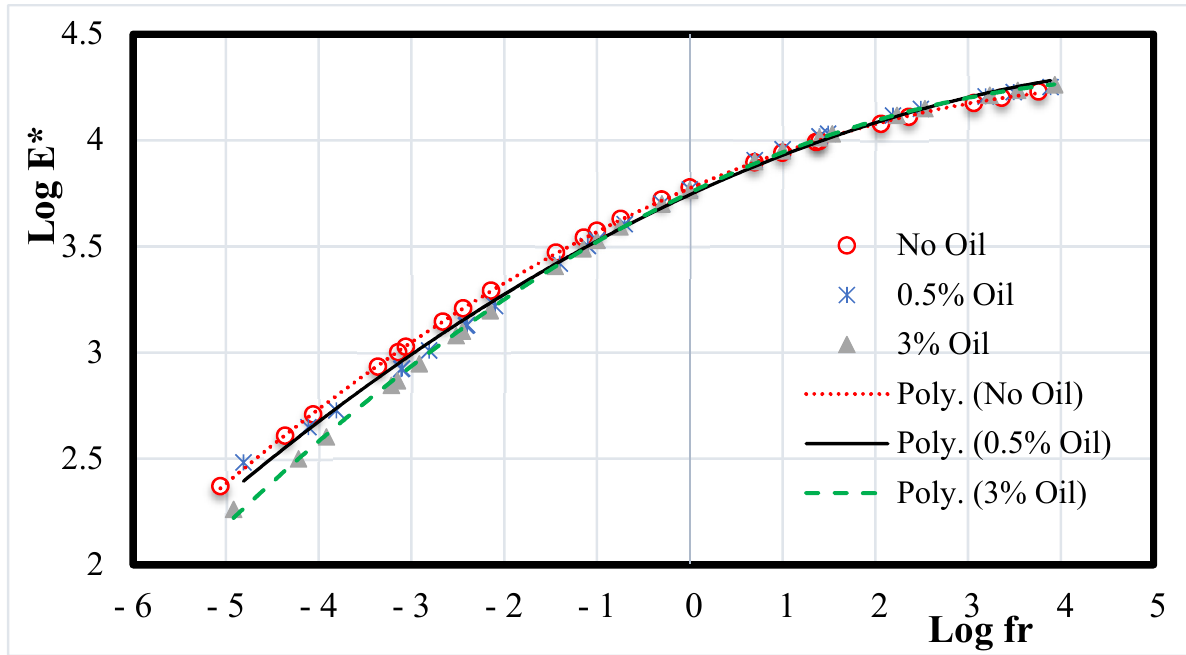
Figure 14. E* Master Curves for Asphalt Mixtures.